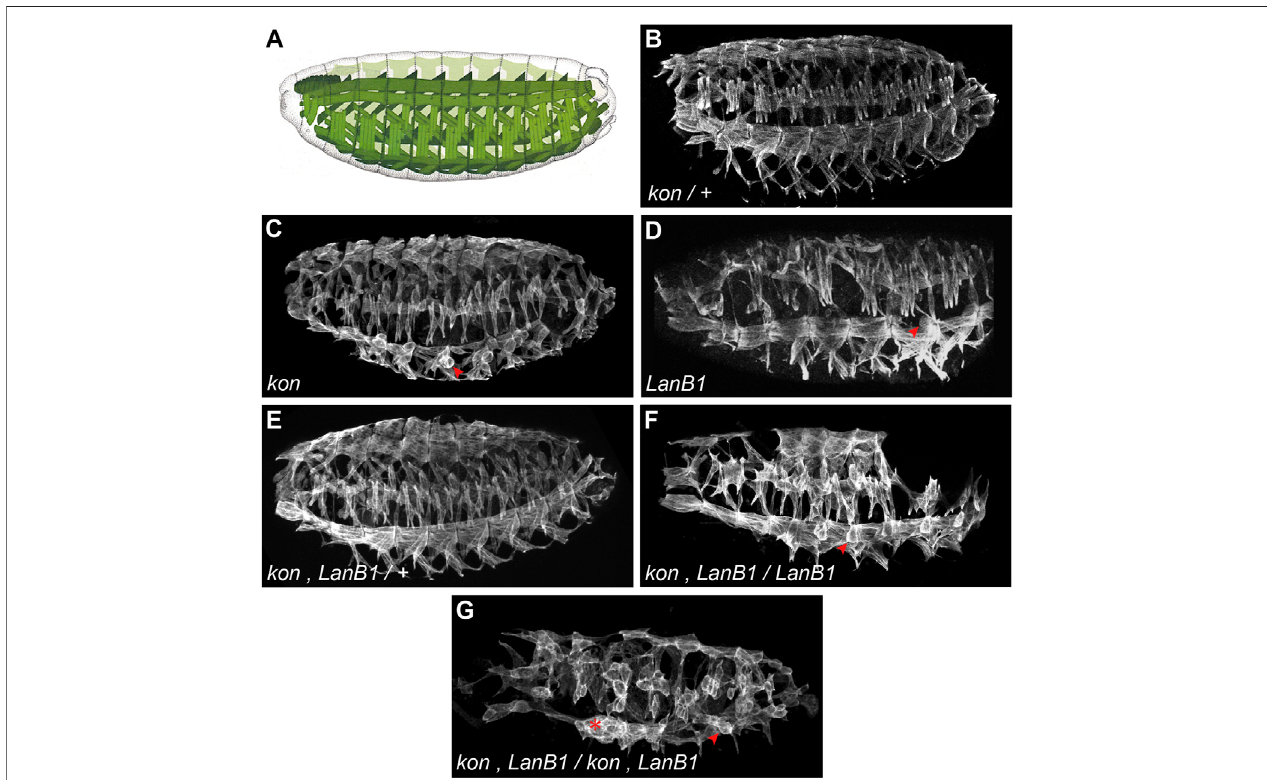
FIGURE 1 | Embryonic pattern of the body wall musculature. (A) Scheme of the Drosophila muscle pattern at the end of embryogenesis (adapted from Bate and Martinez Arias,1993). (B – G) Representativeexamplesofconfocalprojectionsofstage16embryos.Ineachcase,acompletepenetranceoftheshownphenotypeswas observed[ n (cid:1) 12 (B) ; n (cid:1) 9 (C) ; n (cid:1) 4 (D) ; n (cid:1) 5 (E) ; n (cid:1) 5 (F) ; n (cid:1) 24 (G) ].Musclesarelabeledwithanti-Tropomyosin;arrowheadsindicateexamplesofmyospheres;asterisk indicates accumulation of detached muscles.